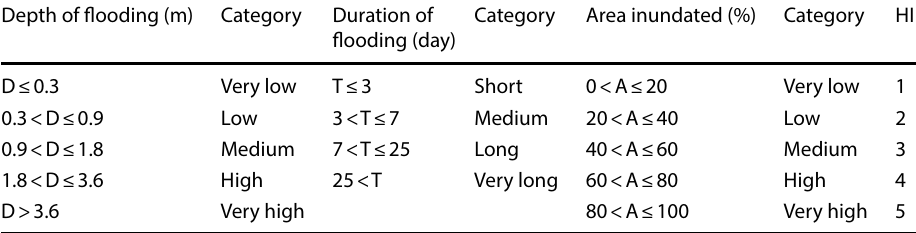
Table 1 Hazard Index for the selected Hazard Indicators